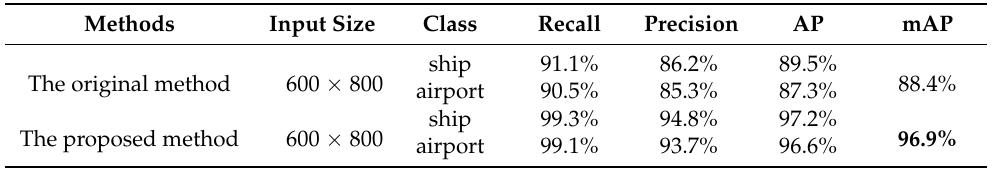
Table 4. Effect of